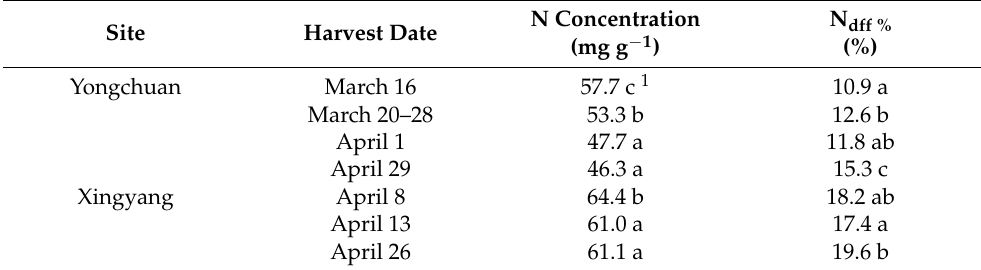
Table 3. Mean N concentration and N dff% of young shoots across fertilization dates.